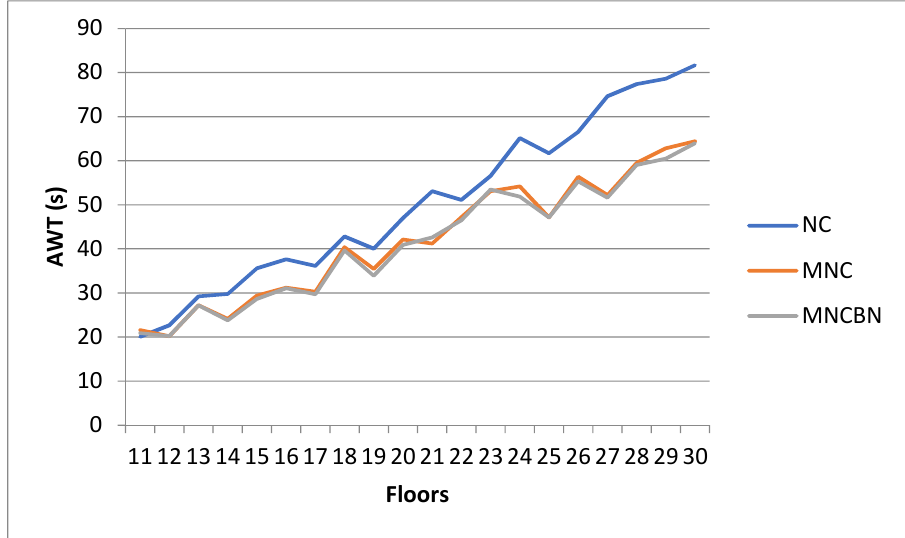
Figure 13. Dependence of AWT on the building height for the random interfloor traffic pattern.